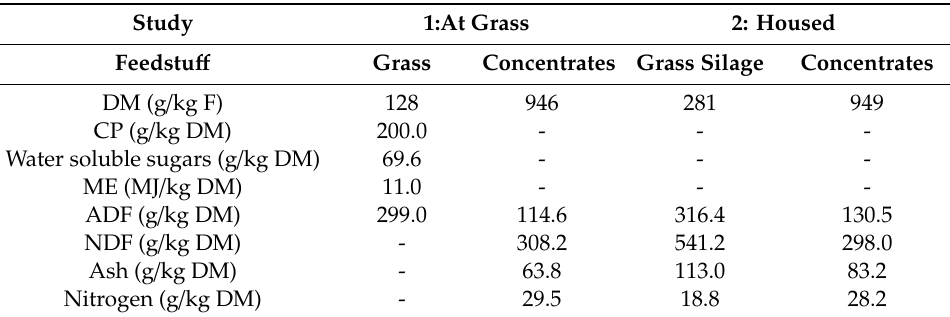
Table 2. Chemical composition of feedstu ff